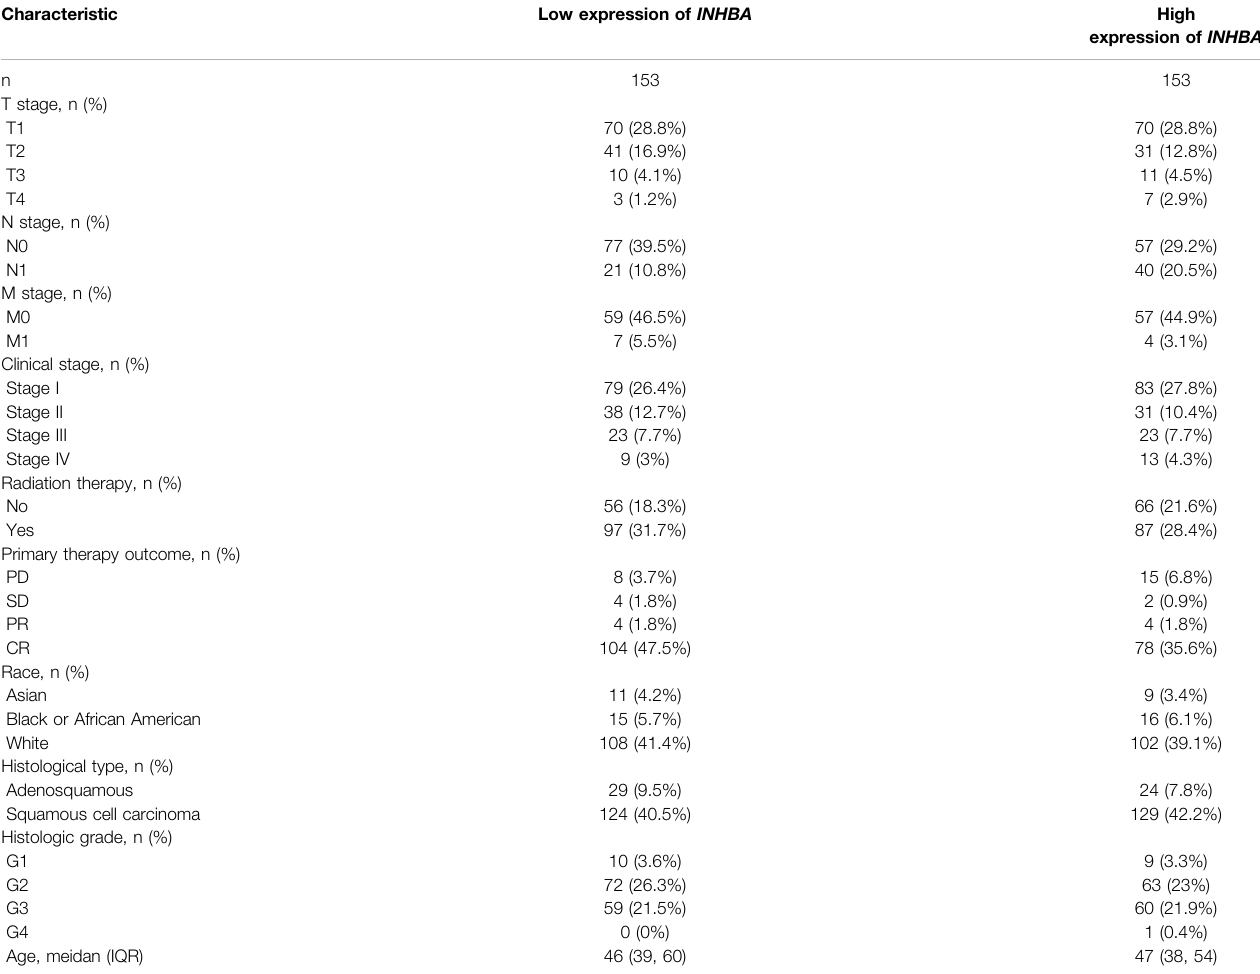
TABLE 1 | Characteristics of cervical cancer patients based on TCGA database.